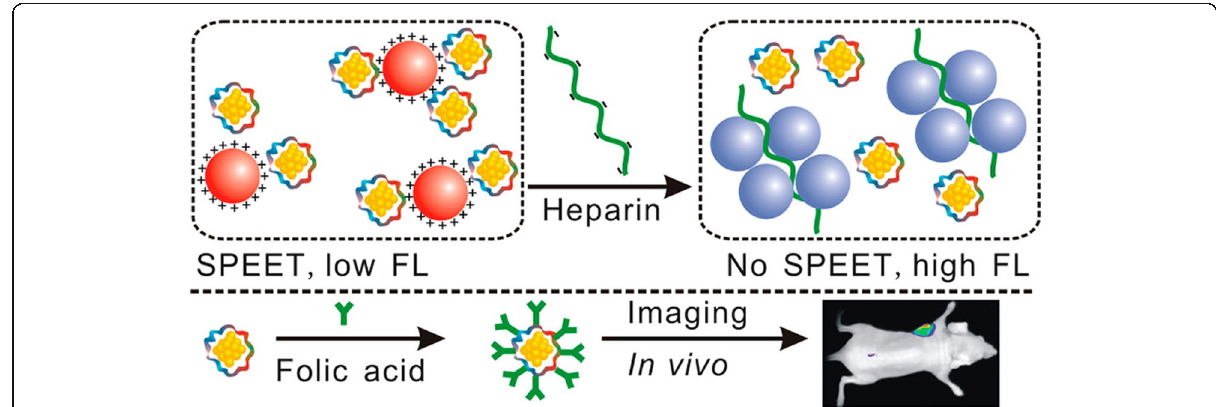
Fig. 3 Near-infrared fluorescent try-AuNCs as surface plasmon-enhanced energy transfer biosensor and in vivo cancer imaging bioprobe